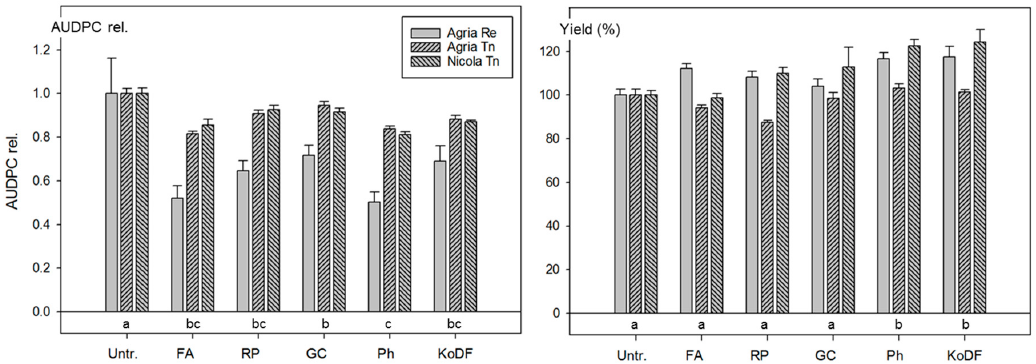
Figure 3. Field experiments in 2011 at Reckenholz (Re) with the potato variety Agria and at Tänikon (Tn) with Agria and Nicola: Effect of suspensions of botanical powders of Frangula alnus (FA), Rheum palmatum (RP) and Galla chinensis (GC), of a treatment with Phosfik ® (Ph) and of the copper fungicide Kocide DF (KoDF) on foliar blight (AUDPC). Treatments are described in Table S3. Untr. = Untreated control. Bars: Mean values of the varieties and standard errors of the means. AUDPC rel.: Area under the disease progress curve relative to the untreated control. Treatments labelled with the same letter are statistically not different (Tukey test p < 0.05).